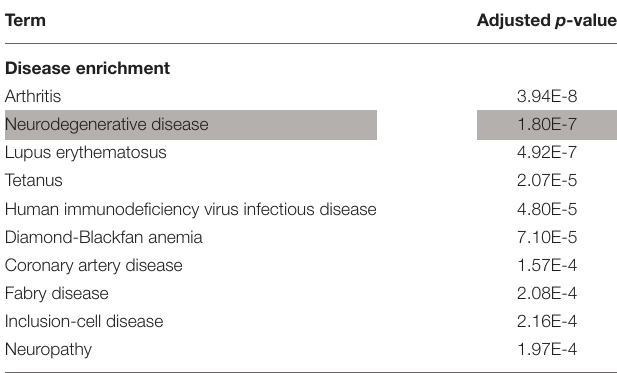
TABLE 6 | Enrichment analysis of the whole list of parent proteins giving rise to MHC class II-binding endogenous peptides in the human B-cell lineage.